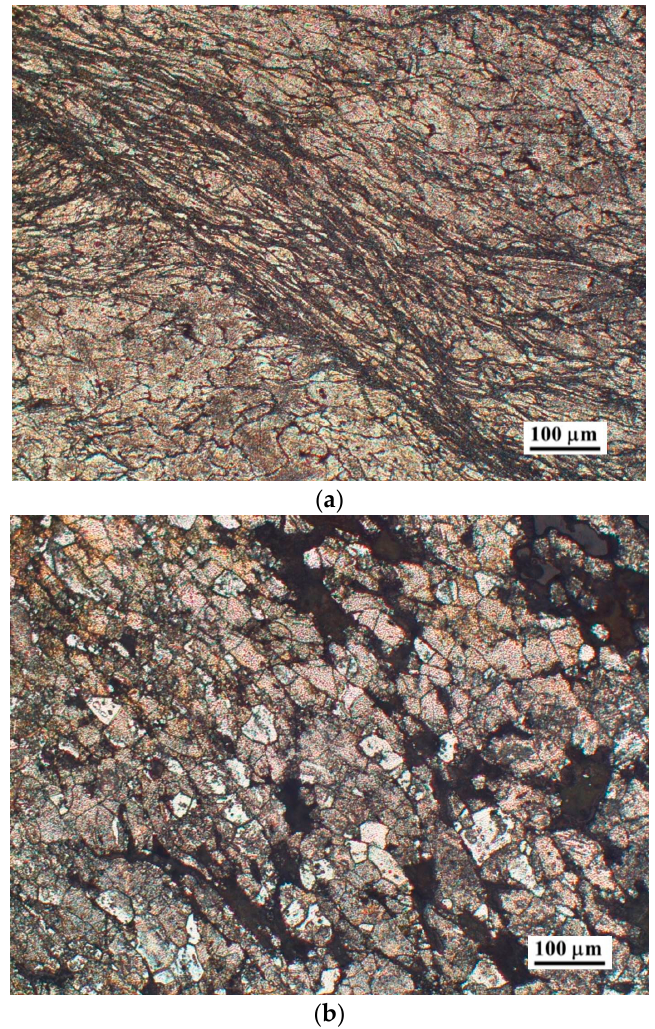
Figure 13. Optical microstructures of the specimens forged at conditions ( a ) 260 °C/1 mm/s and ( b ) at 420 °C/1 mm/s (Corresponding to flow instability). The forging axis is vertical.